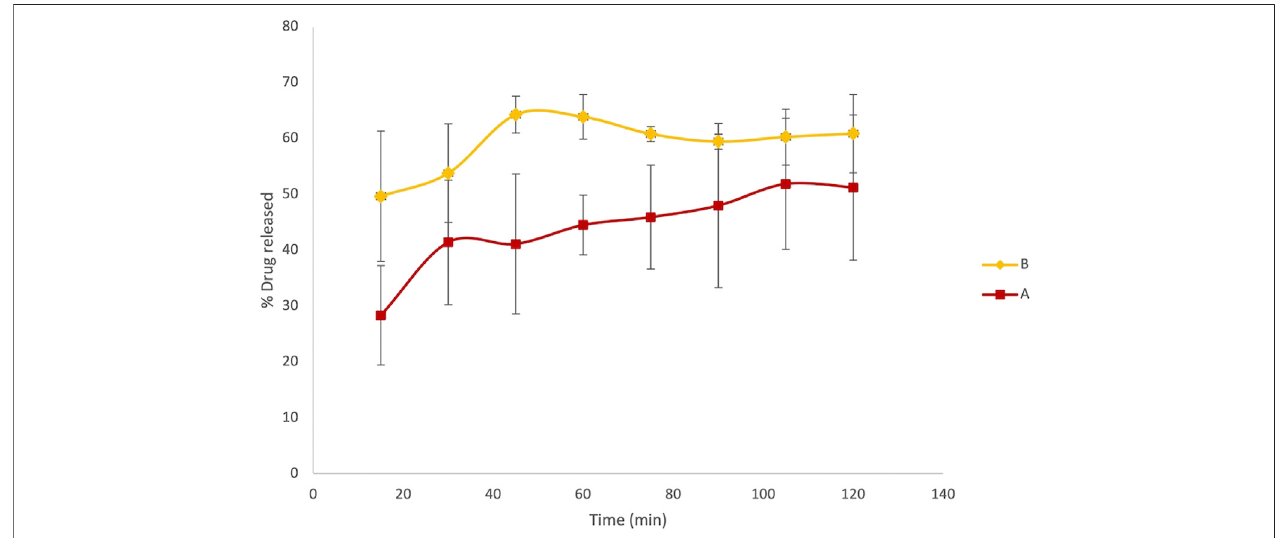
FIGURE 6 | Graph reporting the Pe values for LVN released from both formulations A and B after 30 ′ and 75 ′ dissolution time. The Pe values are plotted against different incubation time in hours. Data are the mean of at least four replicates. RSD% ranged from 7.70 to 70.23%.